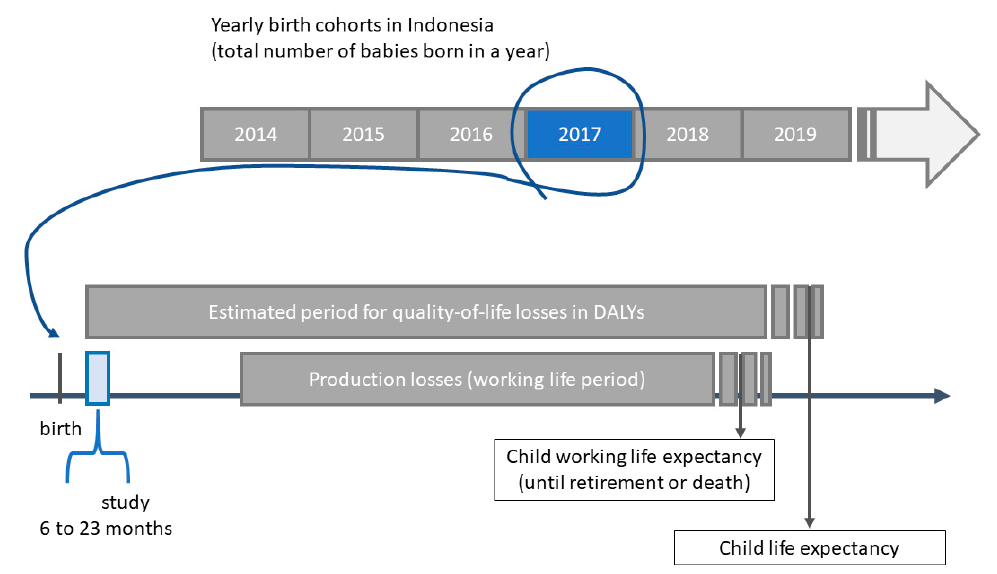
Figure A1. Explanation on the model time frame to estimate temporary and permanent consequences of IDA in a birth cohort.